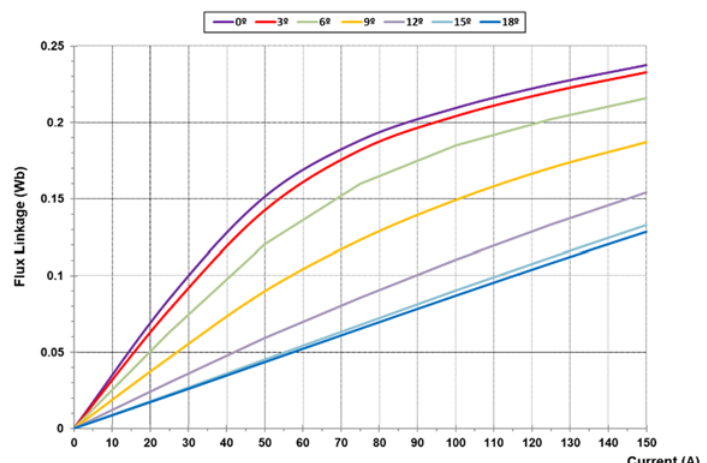
Figure 14. Aligned and unaligned magnetization curves for AFSRM prototype.